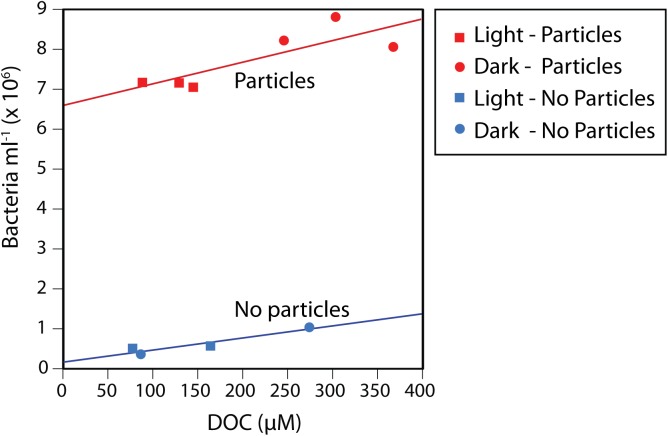
Bacterial cell abundances and dissolved organic carbon (DOC) concentrations in the control and particle addition treatments after a 72 h incubation, showing increased DOC and bacterial concentrations in the particle incubations compared to the no-addition controls, as well as a statistically significant positive correlation between the two variables. This pattern applied to both the incubations with particles and the controls, regardless of being exposed to continuous light or darkness.